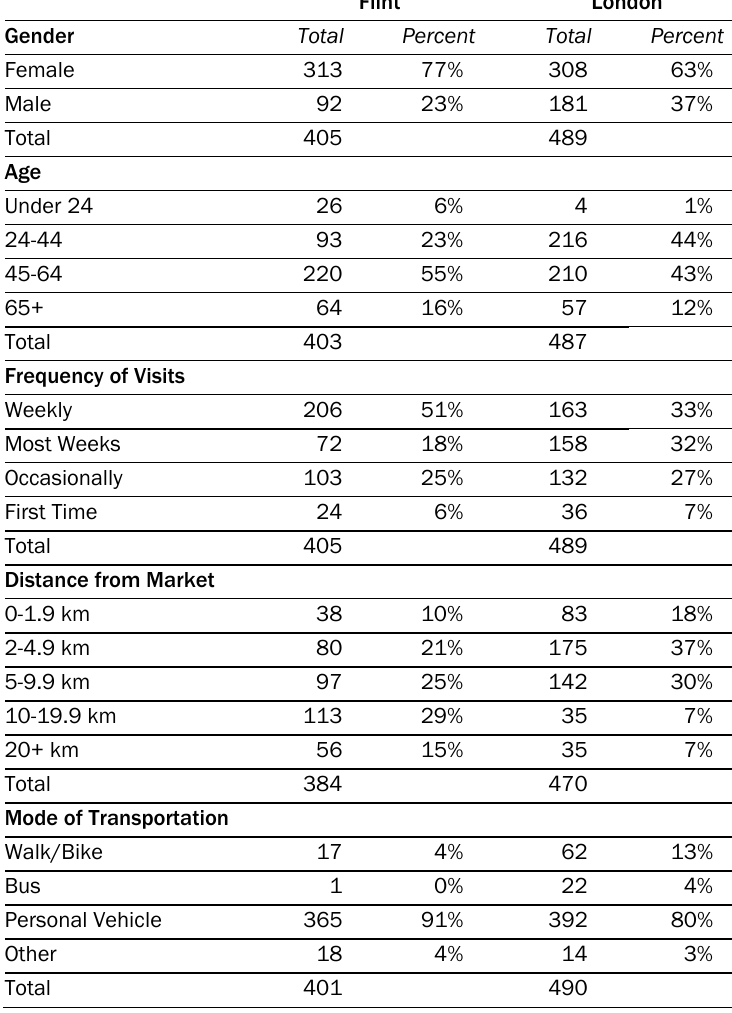
Table 1. Customer Characteristics by